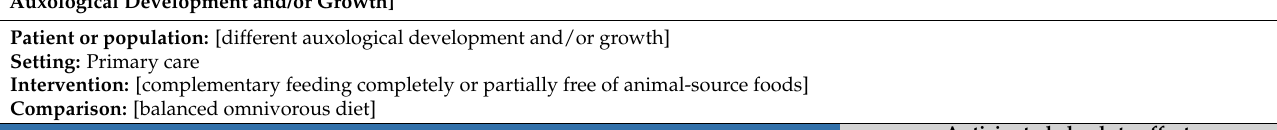
Table 2. Auxological development and/or growth. Summary of findings for the main